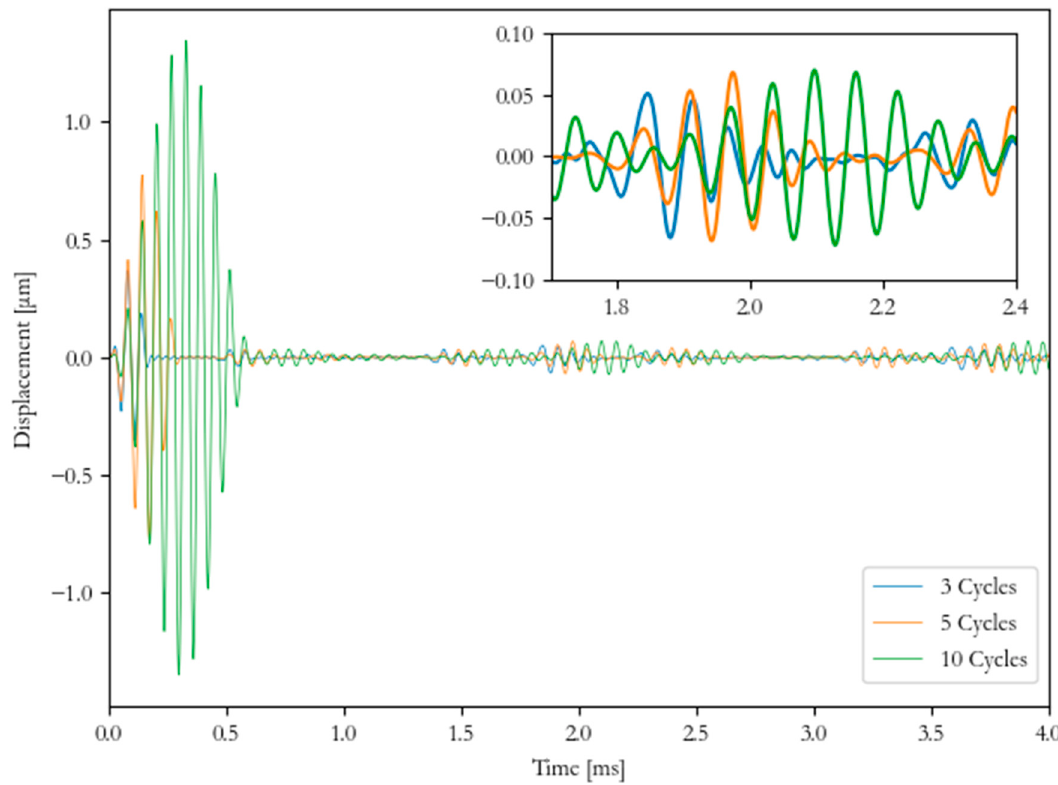
Figure 9. Numerical results of 14 transducer case excited at 16 kHz at a di ff erent number of cycles in time-domain.